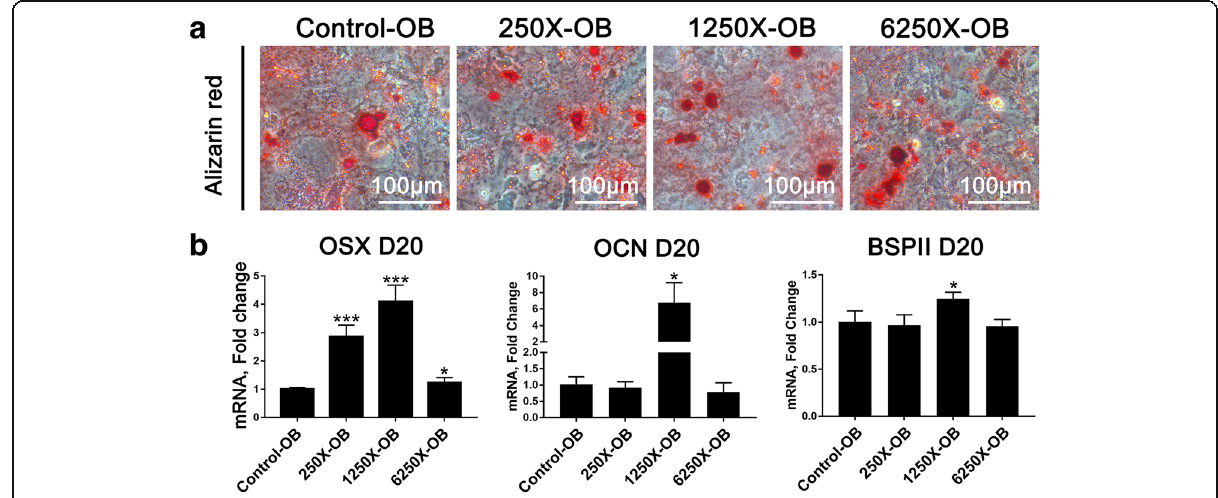
Fig. 4 Effect of different concentrations of Osteoking on osteogenic differentiation of rbMSCs. a Alizarin red staining of rat bone marrow mesenchymal stem cells (rbMSCs) cultured in osteoblast maturation medium with different concentrations of Osteoking after 20 days. X = dilution multiple of Osteoking. b Gene expression analysis for osterix (OSX), bone Sialoprotein II (BSPII) and Osteocalcin (OCN) in rbMSCs cultured in osteoblast maturation medium with different concentrations of Osteoking after 20 days by qRT-PCR. * p < 0.05, *** p < 0.001 vs. control; n =